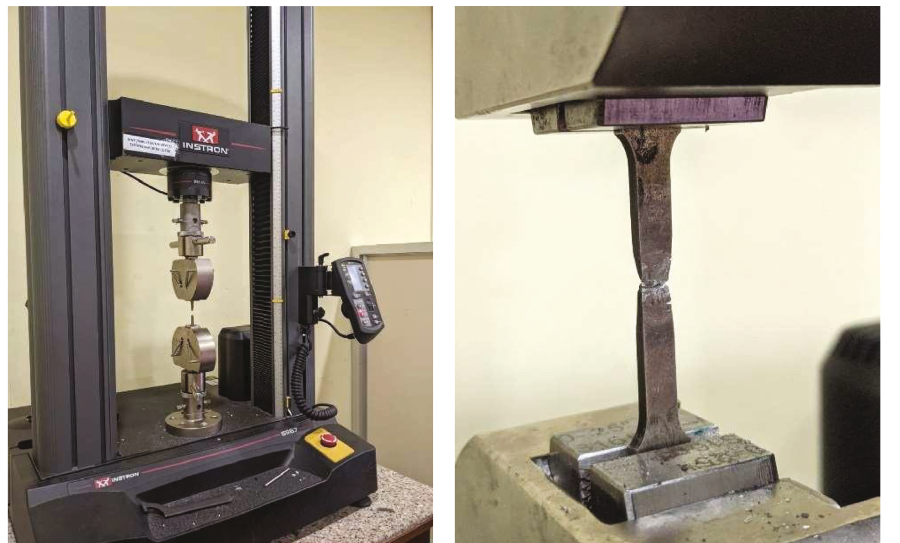
Figure 8: Specimen under a tensile test.